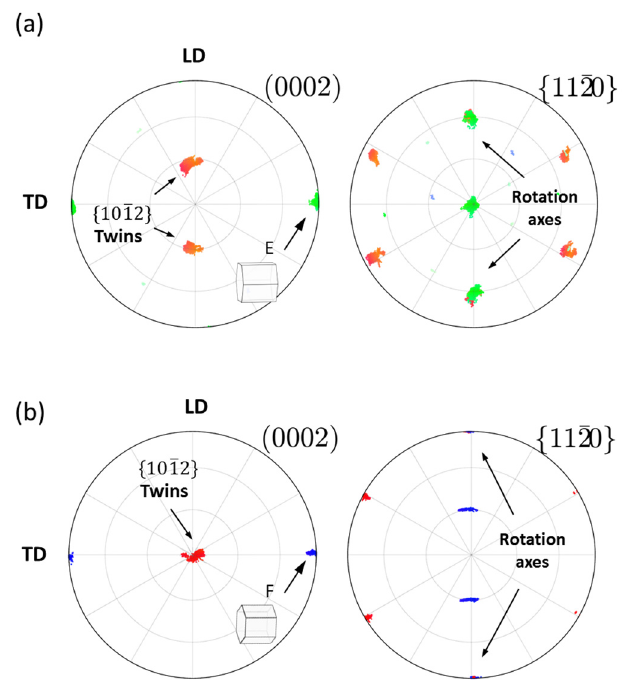
Figure 16. Discrete (sca tt er) pole fi gures for specimens with ( a ) orientation E at a true strain of − 4.8% and ( b ) orientation F at a true strain of − 5.5% obtained by EBSD measurements.